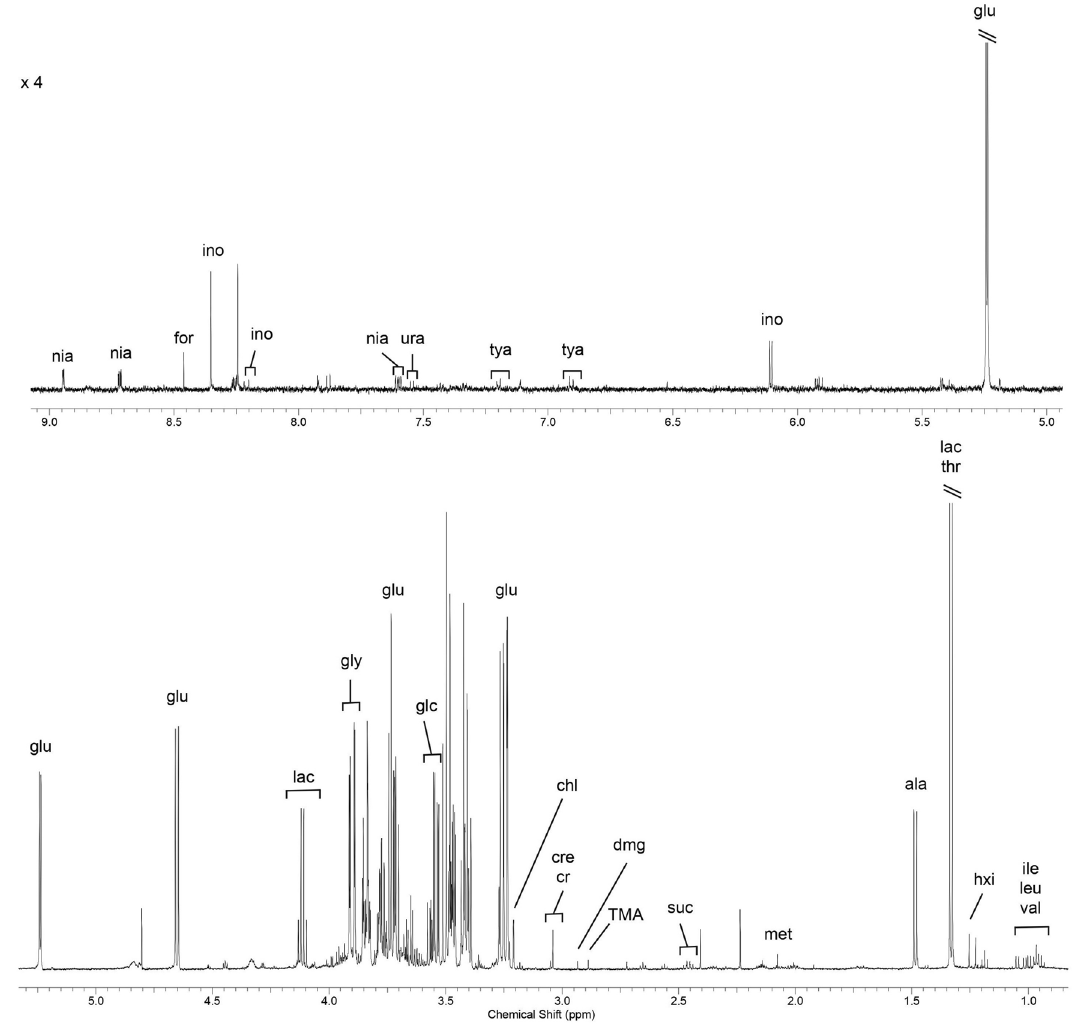
Figure 3. Representative NMR spectrum ( 1 H 1D Presat) of liver aqueous fraction from piglets. Key: val: valine; leu: leucine; ile: isoleucine; hxi: 3-hydroxyisovalerate; lac: lactate; thr: threonine; ala: alanine; met: methionine; suc: succinate; TMA: trimethylamine; dmg: dimethylglycine; cre: creatine/creatine-P; cr: creatinine; chl: choline; glu: glucose; glc: glycerol; gly: glycine; ino: inosine; tya: tyramine; ura: uracil; nia: niacinamide/nicotinurate; for: